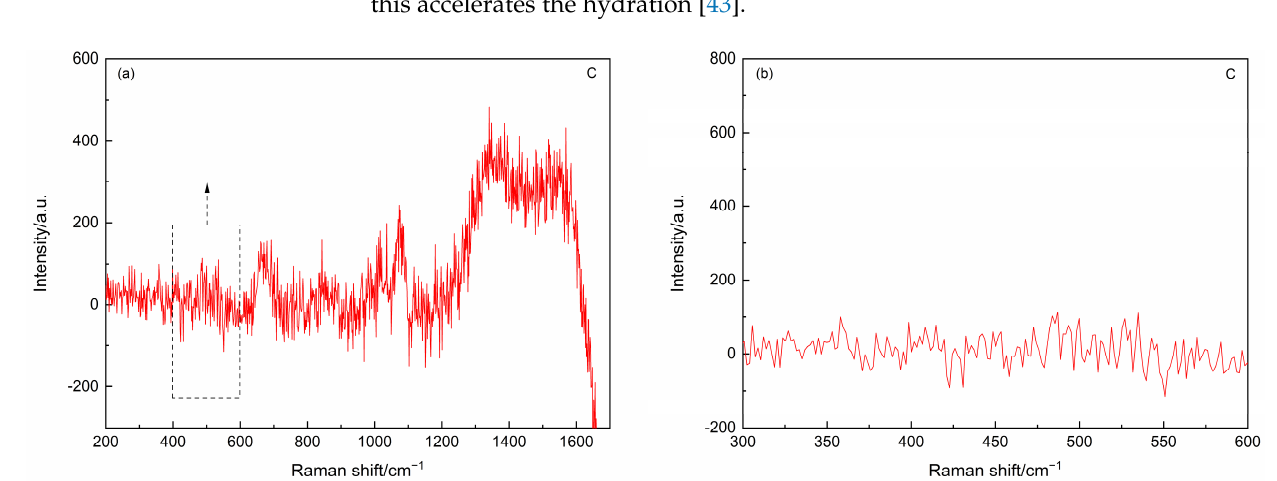
Figure 6. ( a ) Raman spectrum of the point C in Figure 4 after subtracting background. ( b ) Inset of Raman spectrum in ( a ) in the range of 300–600 cm − 1 .